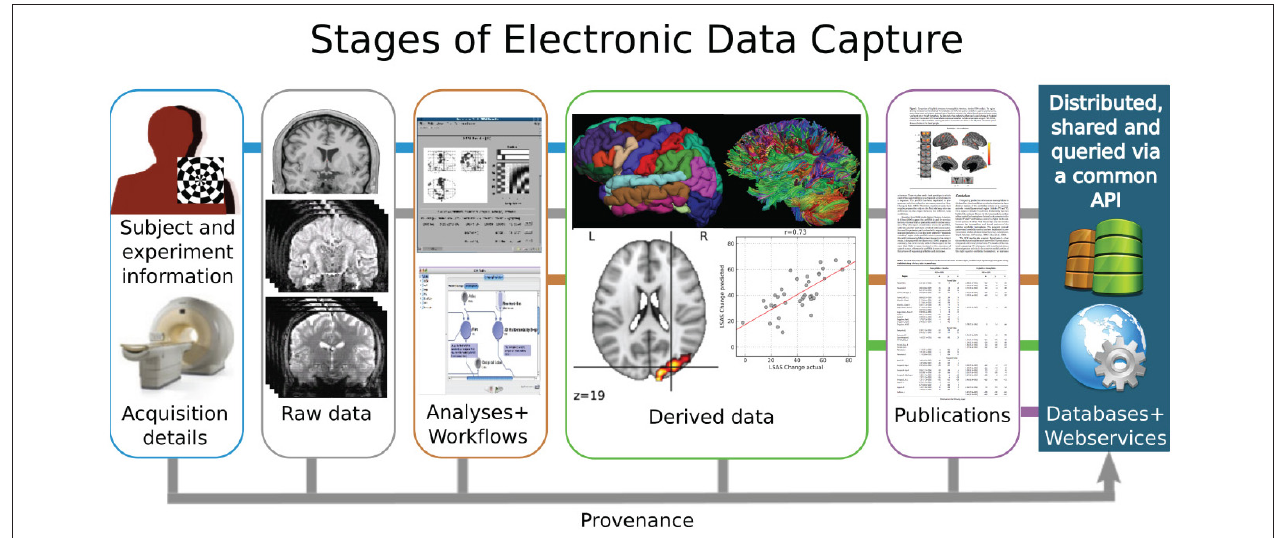
FIGURE 1 | Electronic Data Capture (EDC) workflow for data sharing in neuroimaging